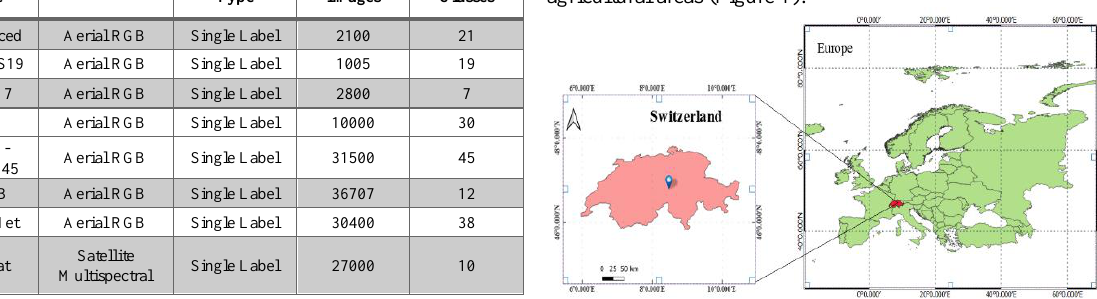
Table 1. A list of remote sensing datasets